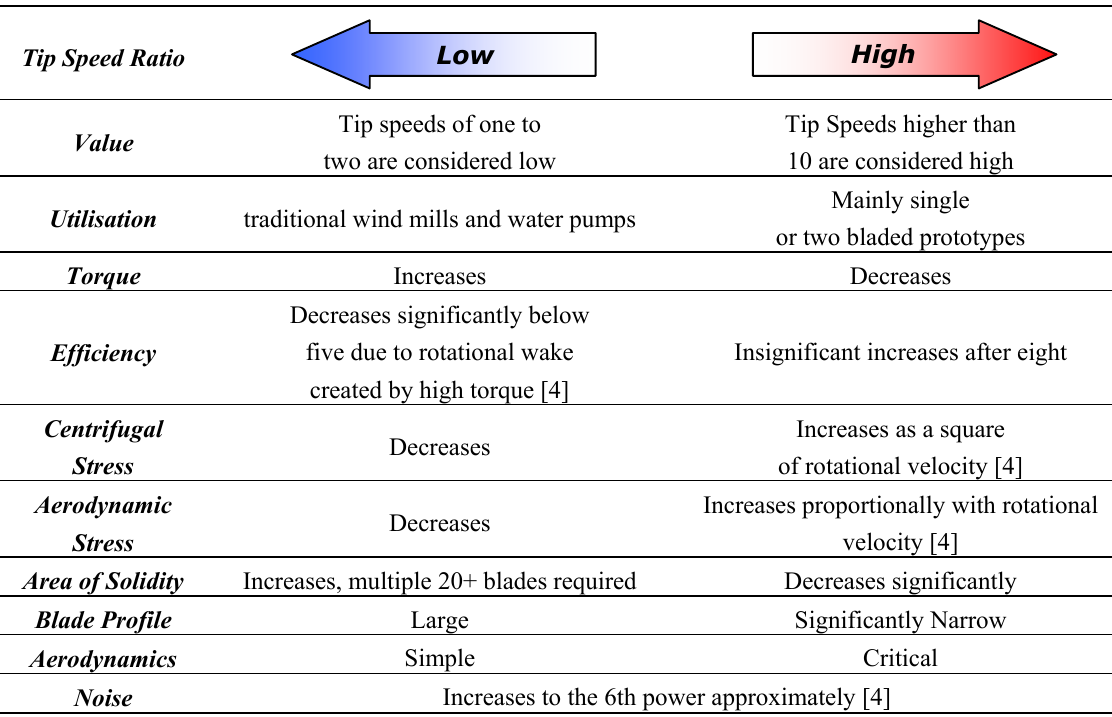
Table 3. Tip speed ratio design